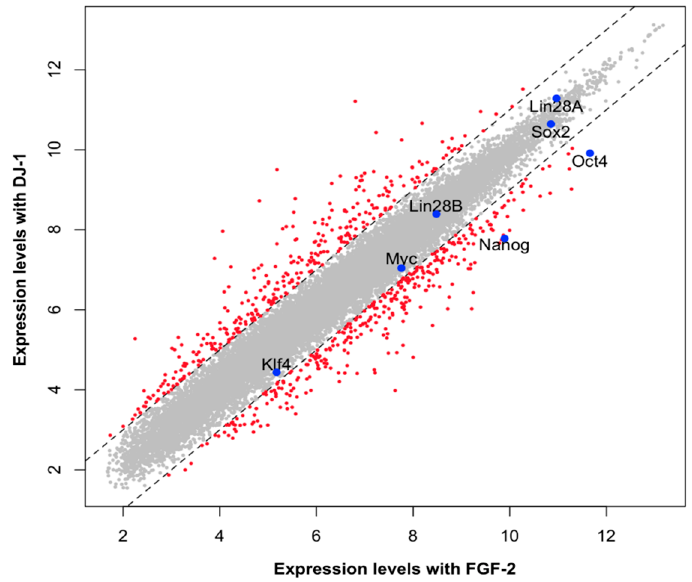
Figure 5. Microarray analysis of H9 hESC cultured in homemade medium containing hFGF-2 or hDJ-1 for ten passages.